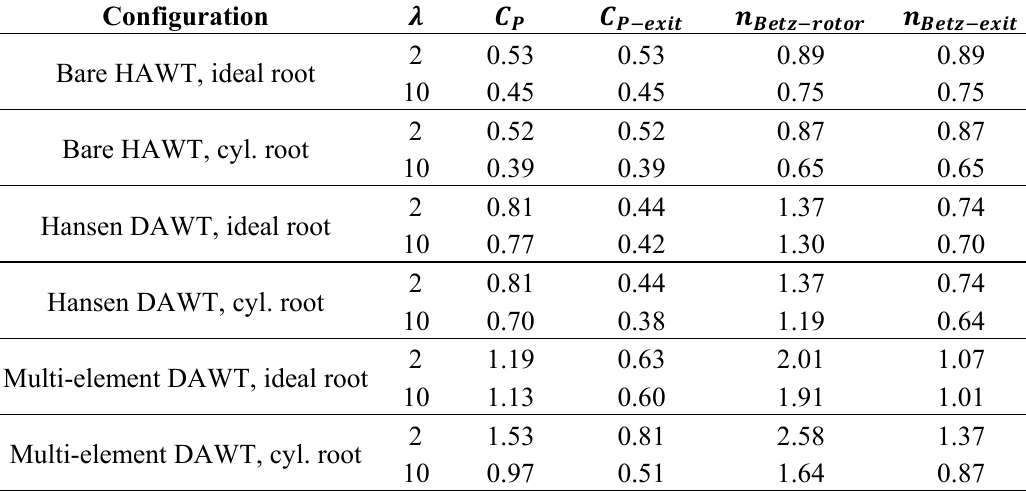
Table 4. Summary of power-optimal performance results ( (cid:1838) (cid:1830)⁄ (cid:3404) 40 ).